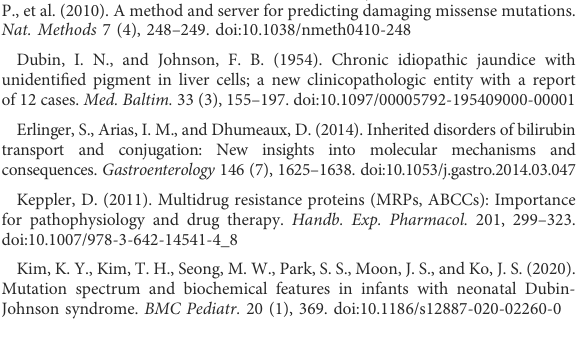
SUPPLEMENTARY FIGURE S1 (A) Ttimelines with relevant data from Patient 1. She was tested for hyperbilirubinemia in 2015 without obvious symptoms. She fell pregnant in November 2017 and, from then on, her jaundice gradually aggravated. The jaundice was in remission after her parturition.However, thehyperbilirubinemiadeterioratedagainafter she took oral contraceptives. She fi nally received genetic testing in July 2021. (B) The bilirubin concentrations were during Patient 1 ’ s pregnancy and drug interventions. She gave birth on 18 August 2018. The drug interventions were conducted from 16 August 2018 to 31 August 2018. TBIL: total bilirubin, DBIL: direct bilirubin. SUPPLEMENTARY FIGURE S2 The image data of the patients. (A-C) The results of Patient 1 ’ s ultrasound examinations. (A) The thickness of her spleen was about 49 mm. (B) The inferior margin of the spleen was about 20 mm below the costal margin. (C) The hemangioma in the liver (about 7.4 mm*7.6 mm). (D ) The CT scan showed that Patient 2 was affected by hepatomegaly. The left lobe of the liver extended to the lower